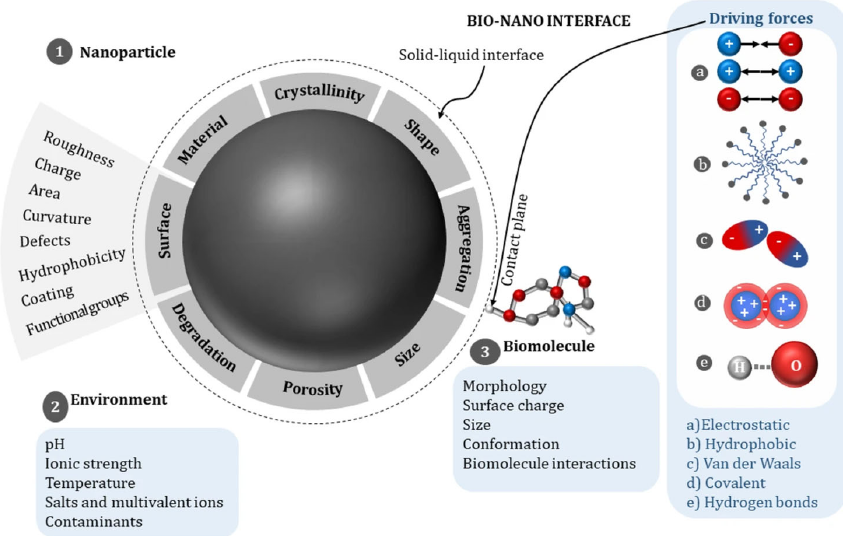
Figure 6. Frontiers constructing the bionano interface, which is constituted by the nanoparticle surface, the biomolecule, and the medium (reproduced without modification with permission from [44]).